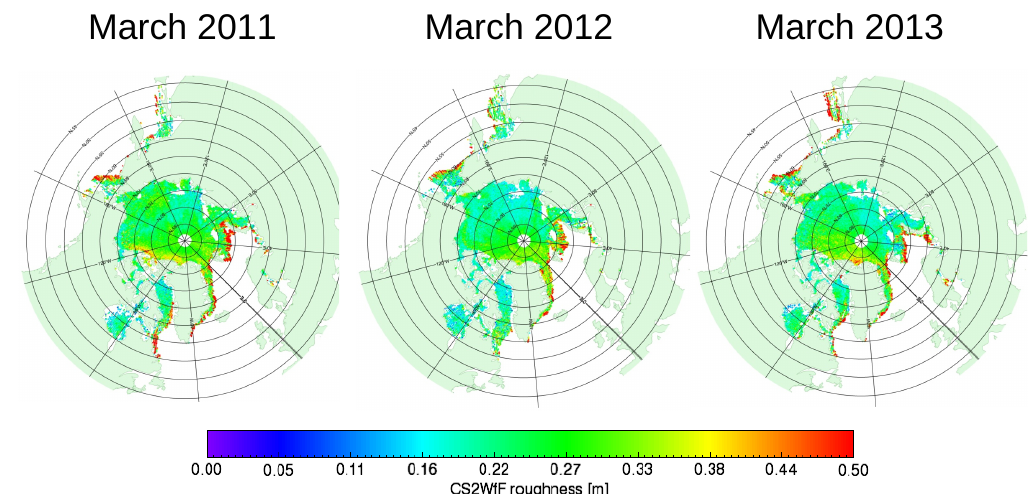
Figure 10. Map of the mean gridded surface roughness, σ , from CryoSat-2 excluding sea ice lead points. Surface roughness from low ice concentration areas near the sea ice edge have also been included; these areas have a high surface roughness due to the presence of ocean